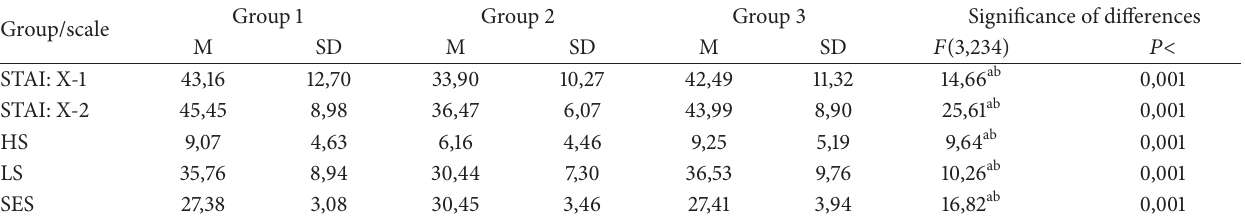
Table 3: Clinical and social-cognitive variables in three groups. Comparison: state anxiety (X-1) and trait anxiety (X-2), hopelessness (HS), loneliness (UCLA LS-R), and self-esteem